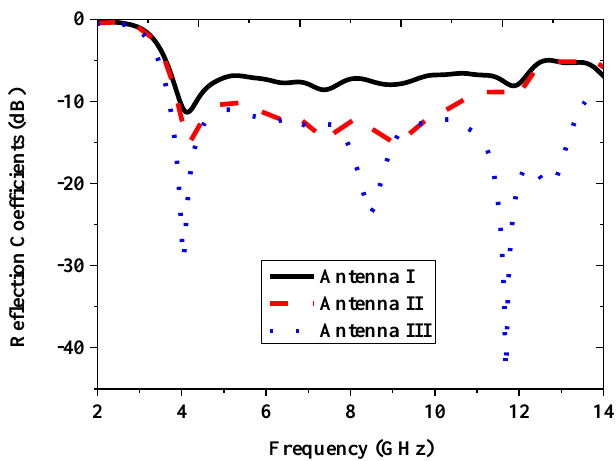
Figure 3. Simulated reflection coefficients of the first three reference antennas.